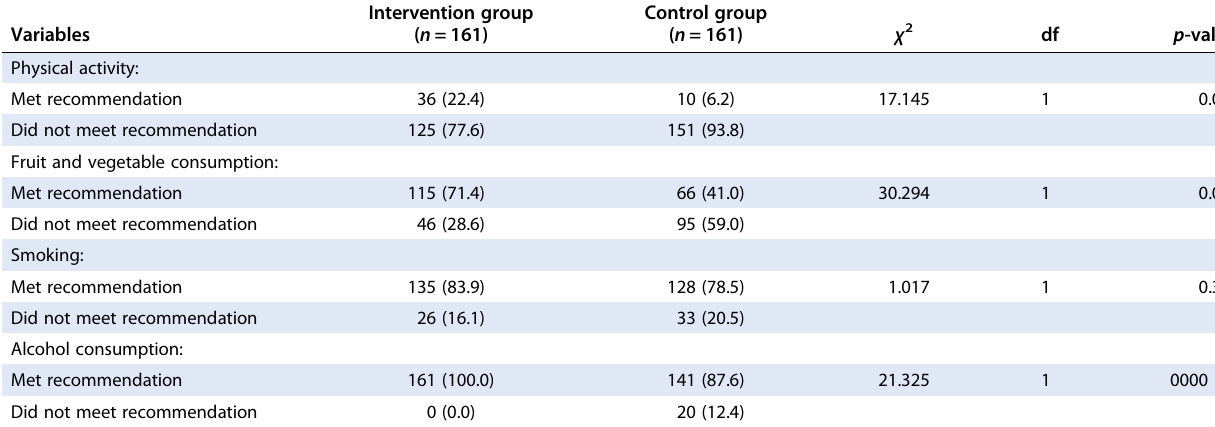
Table 3: Pattern of lifestyle behaviours of respondents post-intervention